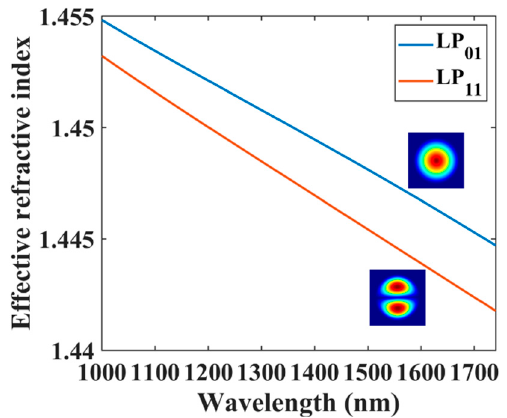
Figure 1. Dispersion curve of the TMF.